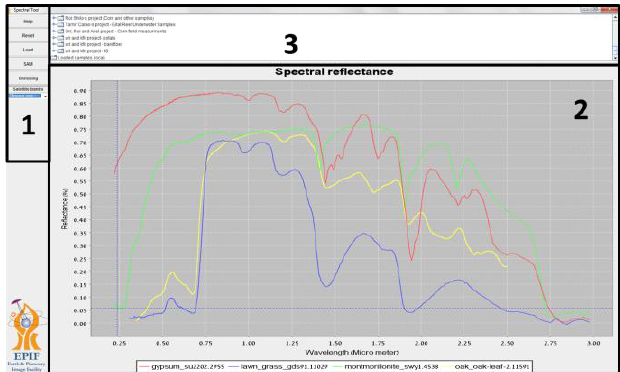
Figure 1. Spec tool GUI display.